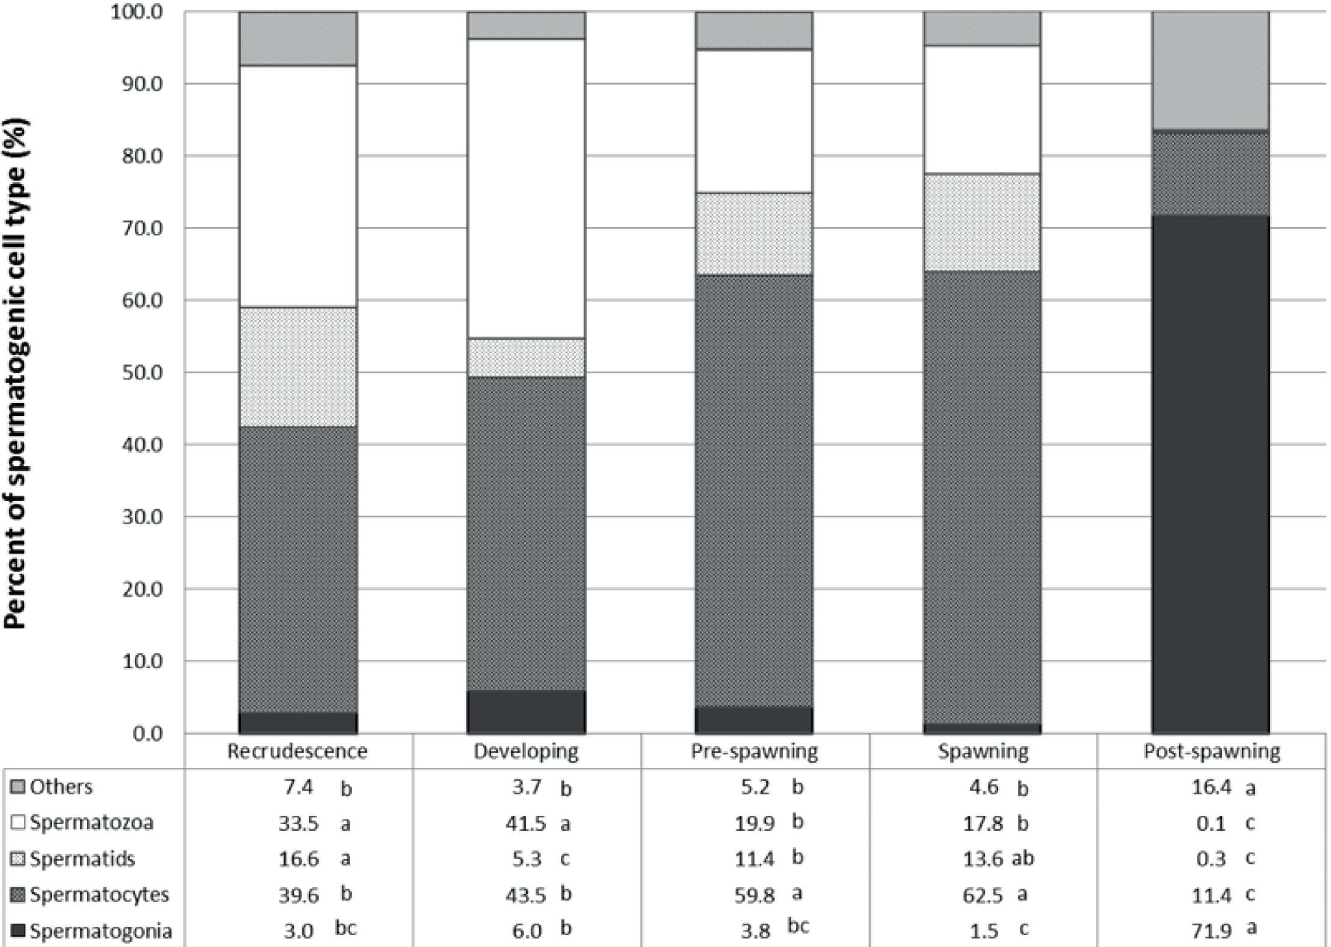
Fig 3. Proportions of gamete stages in the testes of male rainbow darter collected over an annual cycle. Letters signify a statistical difference betweenseasonswithin stages (p <